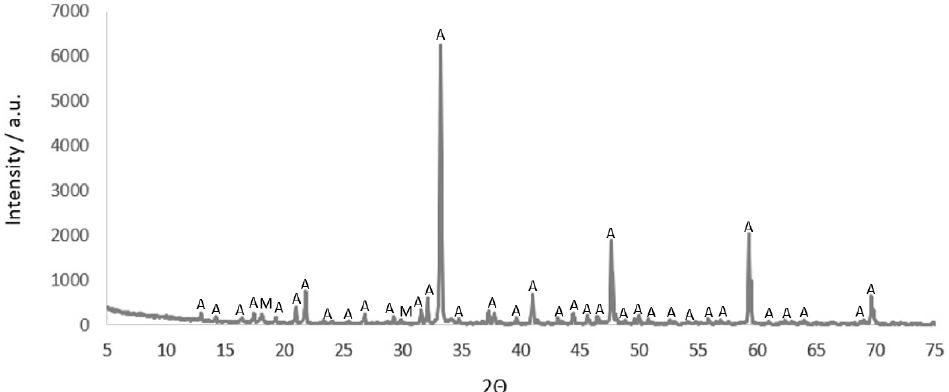
Figure 7. XRD spectrum of anhydrous synthetic tricalcium aluminate C 3 A (sample 1(S)). A — C 3 A; M — C 12 A 7 . M—C 12 A 7